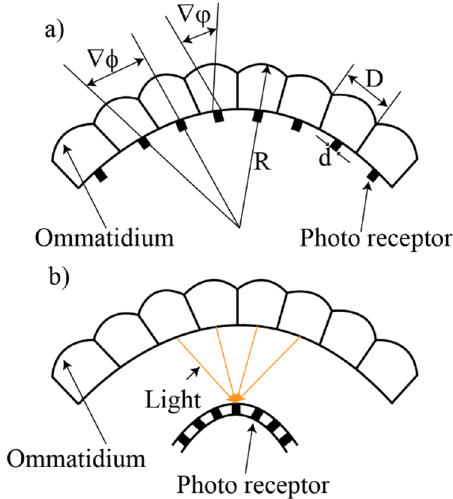
Figure 1. The types of the natural compound eye: ( a ) The apposition compound eye and ( b ) superposition compound eye.